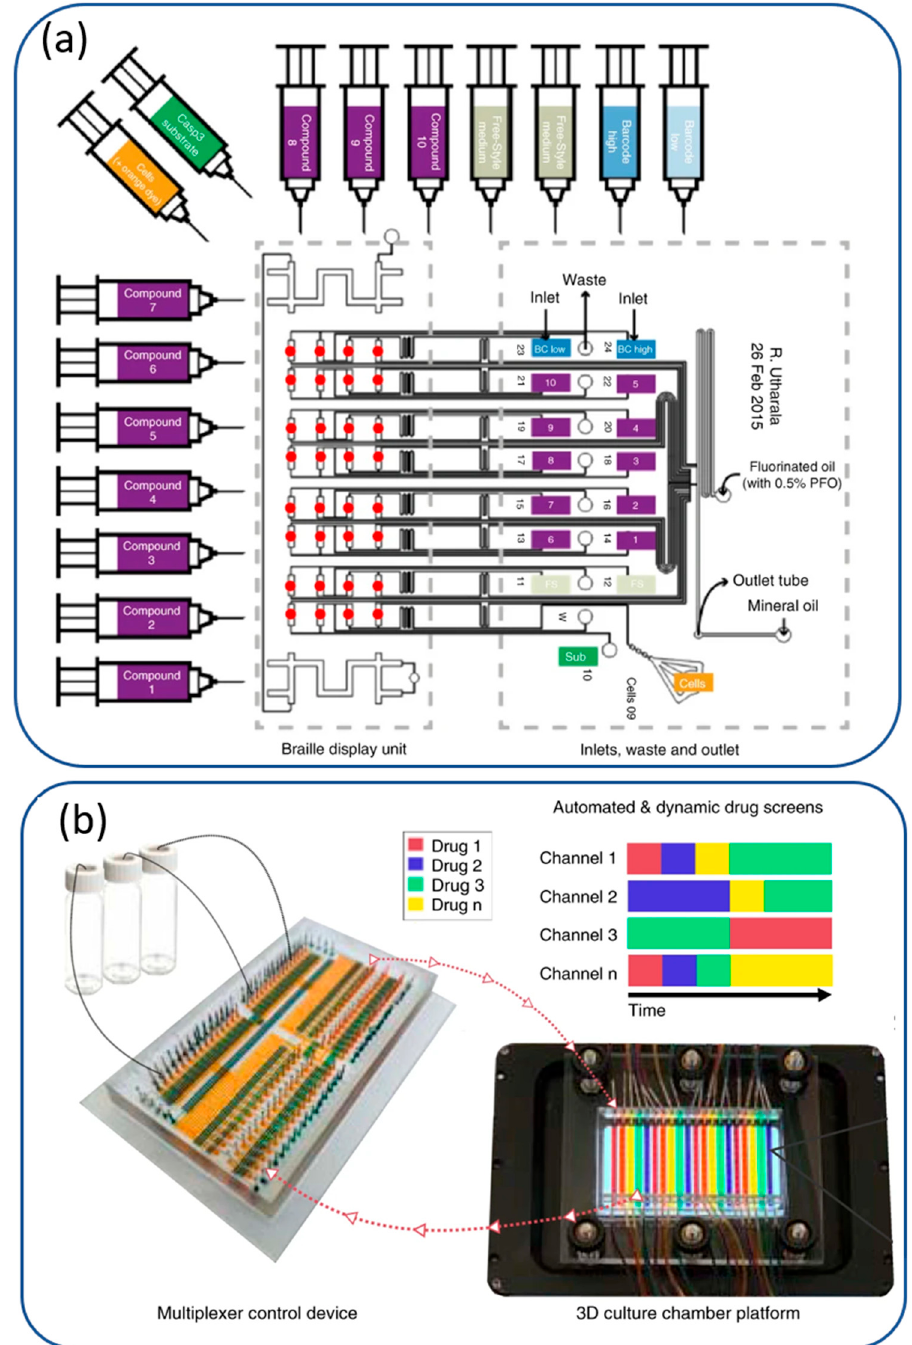
Figure 3. Combinatorial drug screening using ( a ) a plug-based microfluidic device using braille valves designed on pancreatic cancer biopsies. Reproduced with permission from Ref. [56]